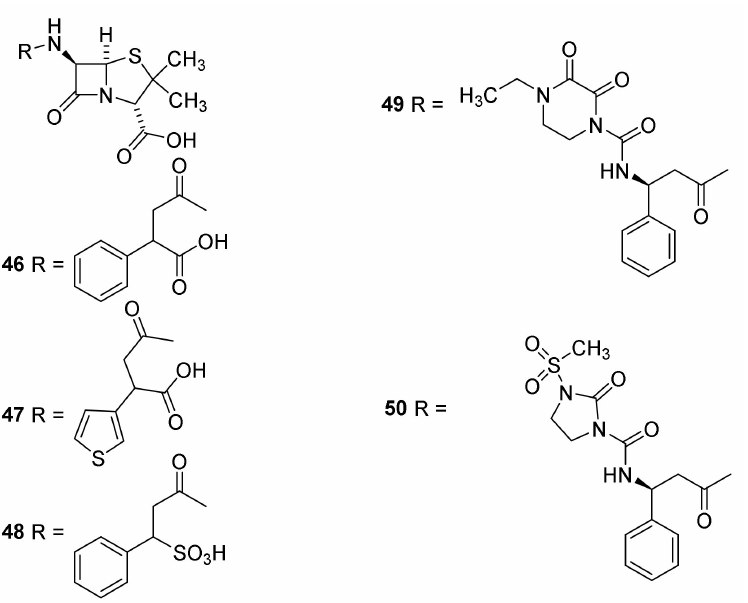
Figure 10. Semisynthetic penicillins with activity toward Pseudomonas aeruginosa Carbenicillin ( 46 ), sulbenicillin ( 47 ), ticarcillin ( 48 ) [44], piperacillin ( 49 ) and mezlocillin ( 50